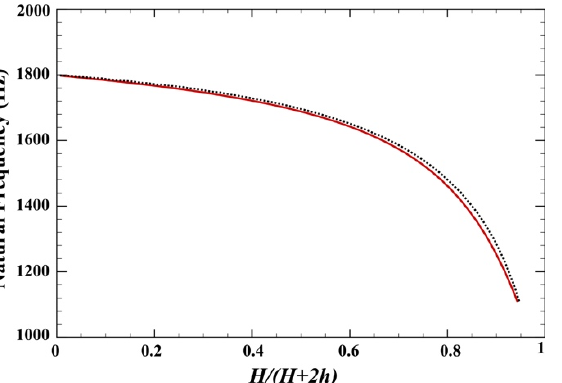
Figure 3. Comparison study of the natural frequencies (Hz) of the honeycomb sandwich cylindrical shell, red solid line: present, black dotted line: Ref [10].